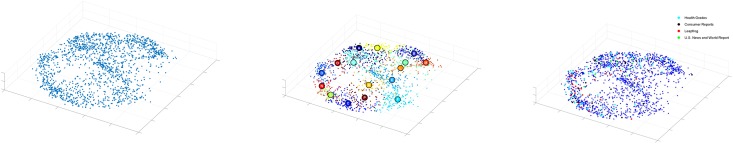
Diffusion maps showing all hospitals (A), hospitals labelled according to their performance profile (B) and top-rated hospitals (C).